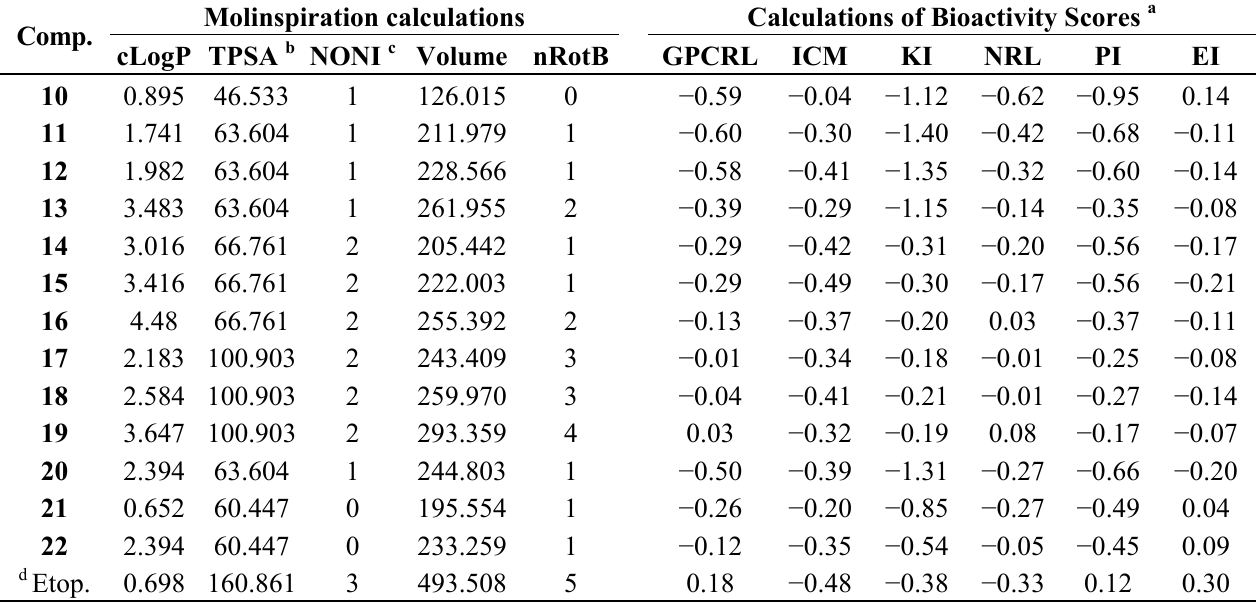
Table 5. Drug-likeness calculations of compounds 10 – 22 by using Molinspiration package.